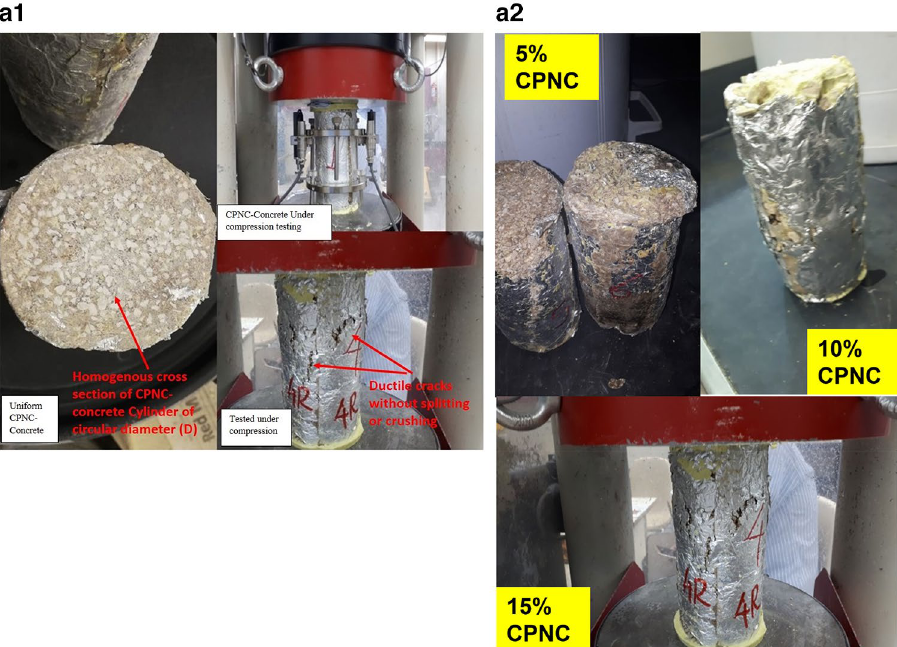
Figure 2. (a1) Compression test of CPNC-Concrete cylinders, Homogeneous cross-section without defects, and ductile failure without crushing. ( a2) Testing of CPNC cylinders under unconfined compressive loading showing ductile failure modes of tested samples with 5%, 10%, and 15% CPNC ratios. There are no splitting or crushing failure modes, similar to Portland cement concrete. The cracking is ductile deformation without sudden failure. ( b) Tensile test of CPNC concrete cylinders showing central cracking without splitting failure, proving ductility. ( c1) Ductile deformation with vertical cracking without the splitting or brittle failure of tensile test cylinder sample of CPNC-concrete, showing changes in the vertical and horizontal diameters a and b, respectively, proving ductility. ( c2) Cracking mode of CPNC concrete tensile strength test without splitting with different CPNC ratios (5%, 10%, and 15% CPNC) relative to Portland cement concrete splitting under compressive loading based on the ASTM standard, as shown in ( b,c1 ), proving that CPNC concrete is ductile without sudden failure or crushing. Additionally, the typical failure mode of Portland cement concrete cylinders under compressive loading is shown in the figure for the tensile strength test; the cylinders fracture, and the failure is splitting at the vertical centreline of the cross section. In recent CPNC concrete, there is no splitting, sudden cracking or crack propagation; instead, there is ductile deformation of the cross section of the cylinder, as shown in the ( b,c1,c2